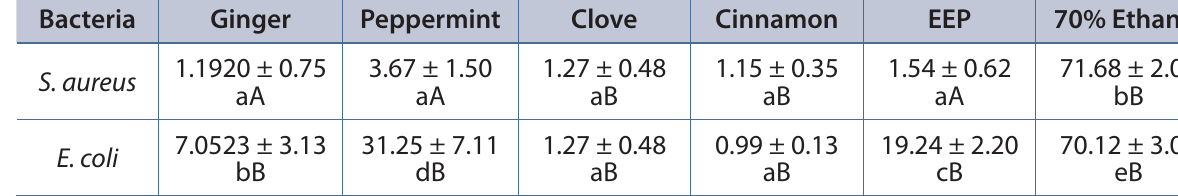
Table 2. Mean and standard deviation of minimal inhibitory concentration (MIC) values (mg x mL –1 ) for all antimicrobials against S. aureus and E. coli strains Bacteria